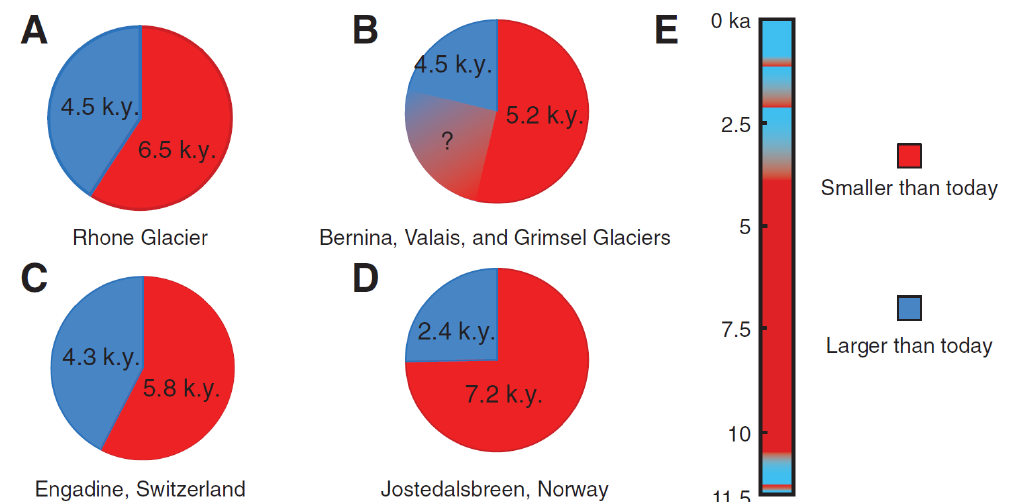
Figure 4. Schematic presentation of the time periods where European glaciers were smaller (red) and larger (blue) than today. The figure is adapted from the work of Goehring et al . [17]. “Nearby proxy records indicate that at least most of the time during which the Rhone glacier was smaller than today was during the early to mid-Holocene” [17]. In E the hypothetical Holocene advance and retreat scenario of the Rhone Glacier is displayed, indicating the glacier was smaller than today during the first part of the